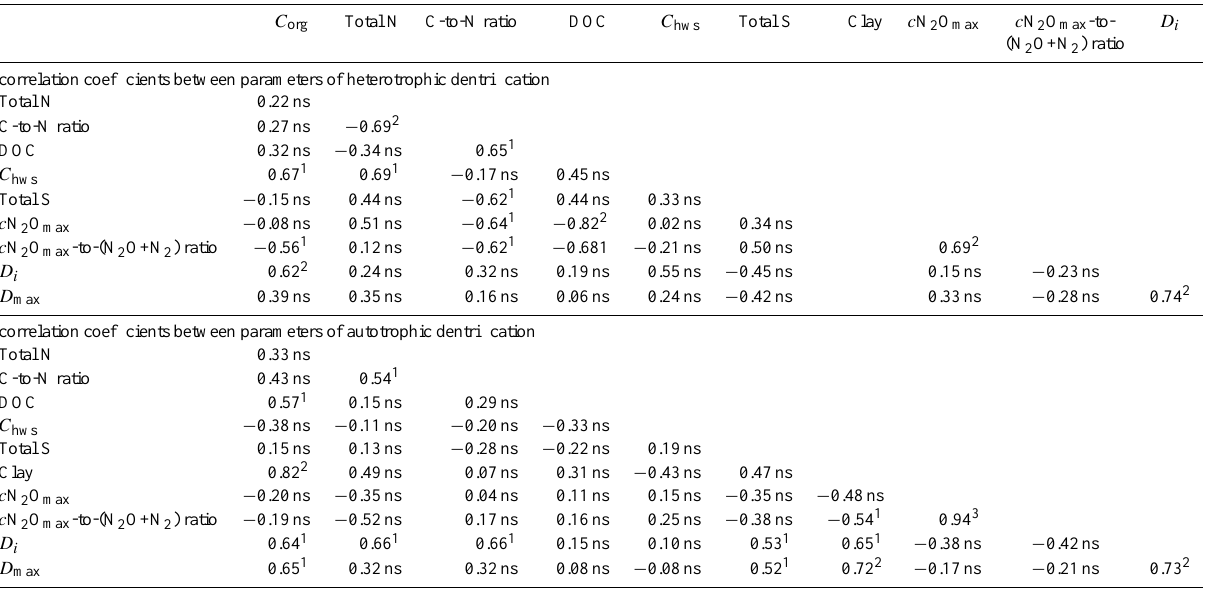
Table 3. Spearman rank correlation coefficients between the parameters obtained from the laboratory incubation experiments for the het- erotrophic and the autotrophic data set. Clay was not detectable in the aquifer material of the heterotrophic denitrification zone and was thus excluded from the correlation